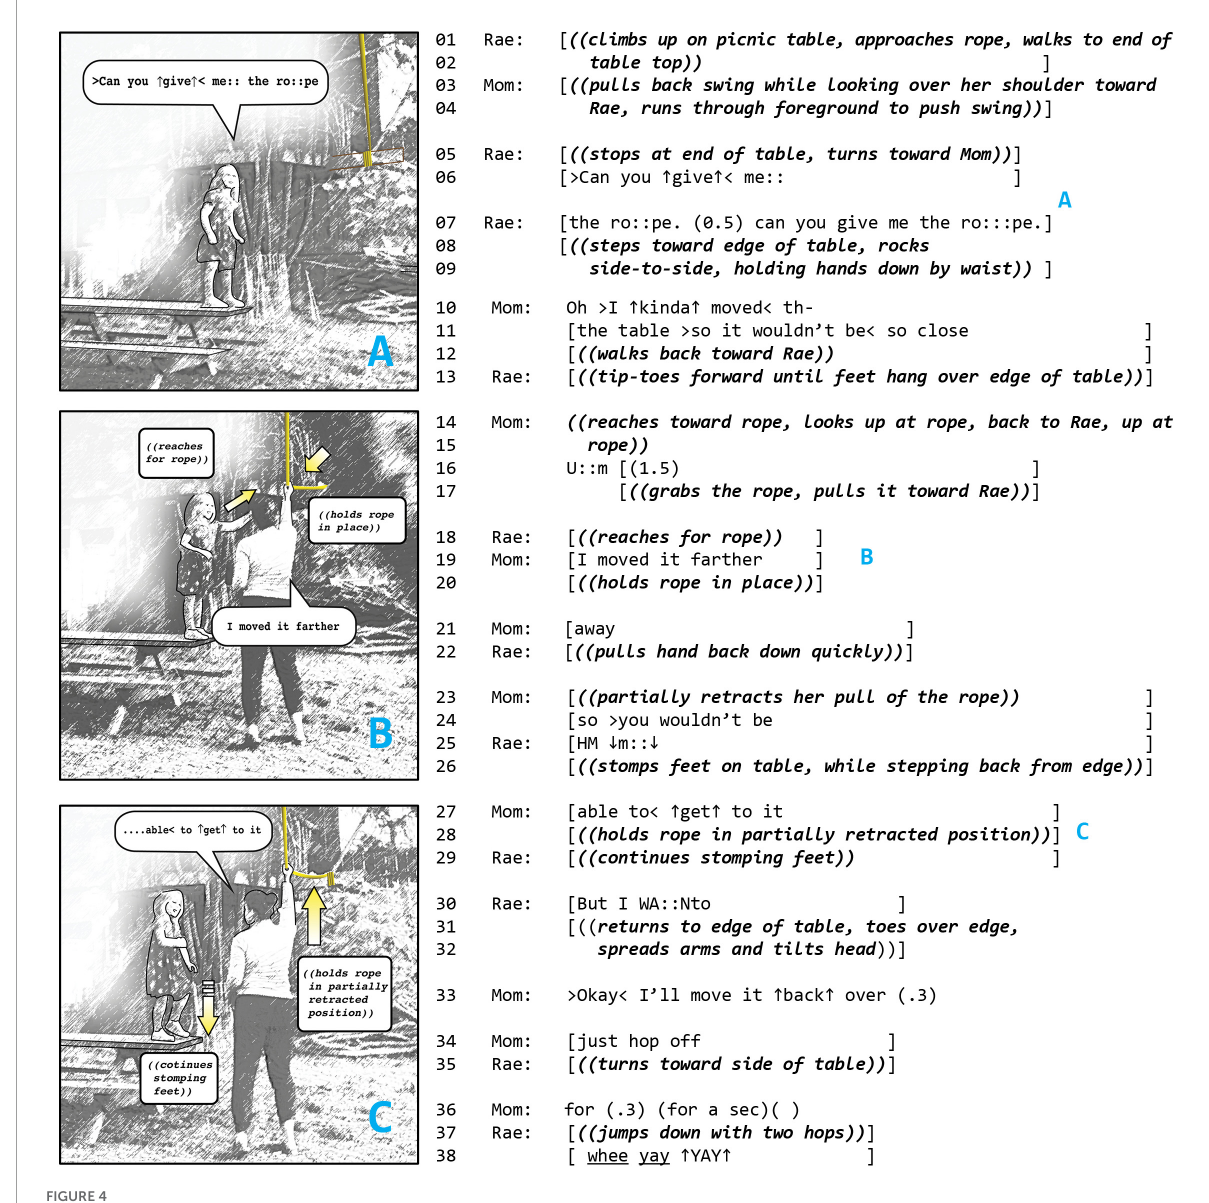
FIGURE4 Rae requests